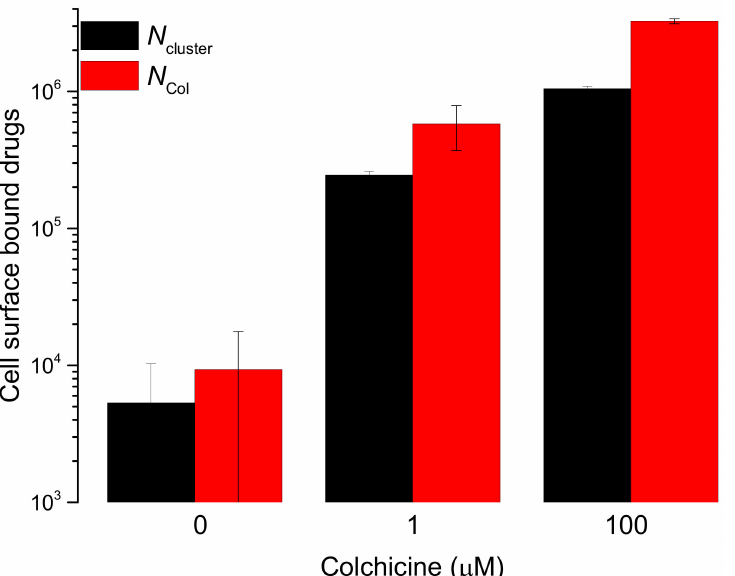
Figure 3. Cell surface bound/adsorbed colchicine molecules ( N Col ) and cell surface clusters of the colchicine molecules ( N cluster ) have been plotted (y-axis) as histograms at the cell treating 0 (control), 1 and 100 µ M colchicine concentrations. Both sets of data represent the mean ± S.D., n = 3. The number each histogram represents is the counted number of clusters against a particle height profile (see Figure 2b and Supplementary Figure S5b). The height profiles are recorded at the centers of the corresponding clusters in Supplementary Figure